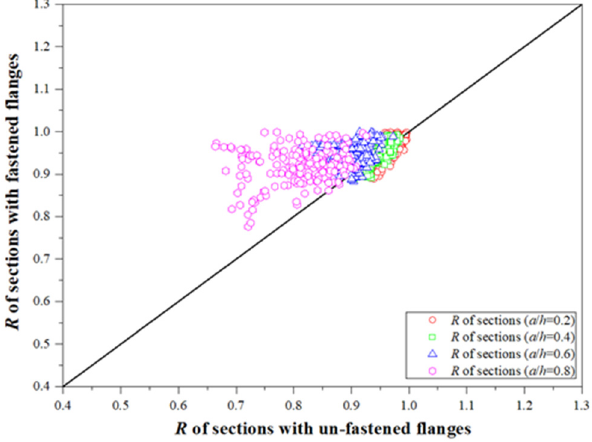
Figure 9. Web crippling strength reduction factor against unfastened/fastened flanges. Table 4. Average web crippling strength reduction percentage (%) of investigated sections at ele- vated temperatures against ambient temperatures ( T = 20 °C).